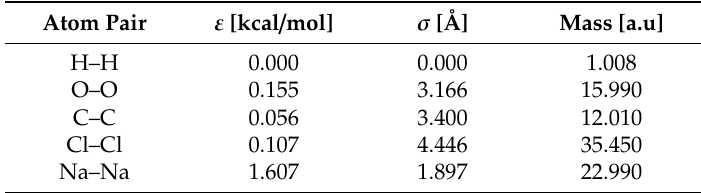
Table 2. Potential parameters for all atomic